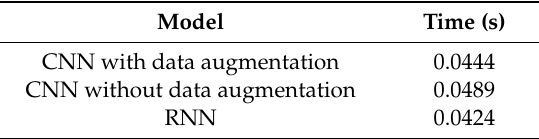
Table 1. Calculation time of three dual-output